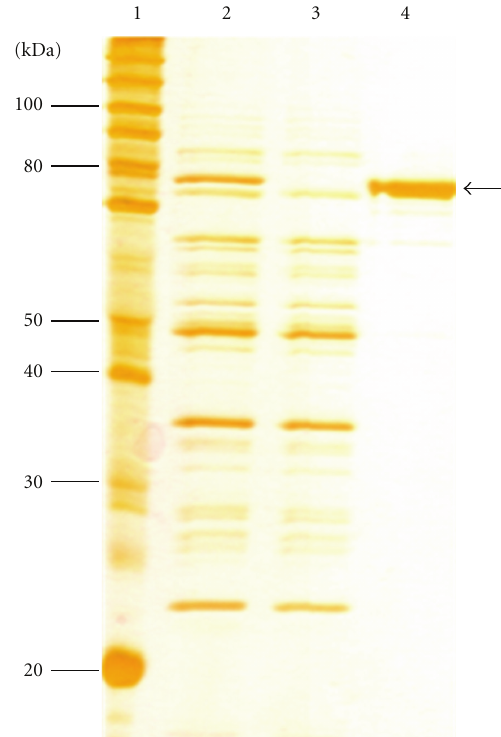
Figure 1: SDS-PAGE (12%) profile showing the expressed and purified recombinant Cry1Ia12 protein. Lane 1: Marker BenchMark Protein Ladder (INVITROGEN). Lane 2: E. Coli crude extract induced with 1mM IPTG after 16h expressing recombinant Cry1Ia12 protein, sonicated and centrifuged. Arrows indicate the expressed 74-kDa recombinant Cry1Ia12. Lane 3: Noninduced E. Coli strain BL21Star (DE) containing the expression vector without insert was used as a negative control of the expression. Lane 4: Recombinant Cry1Ia12 protein purified by using Ni-NTA column. Arrow shows the expected purified 74-kDa recombinant Cry1Ia12 protein.